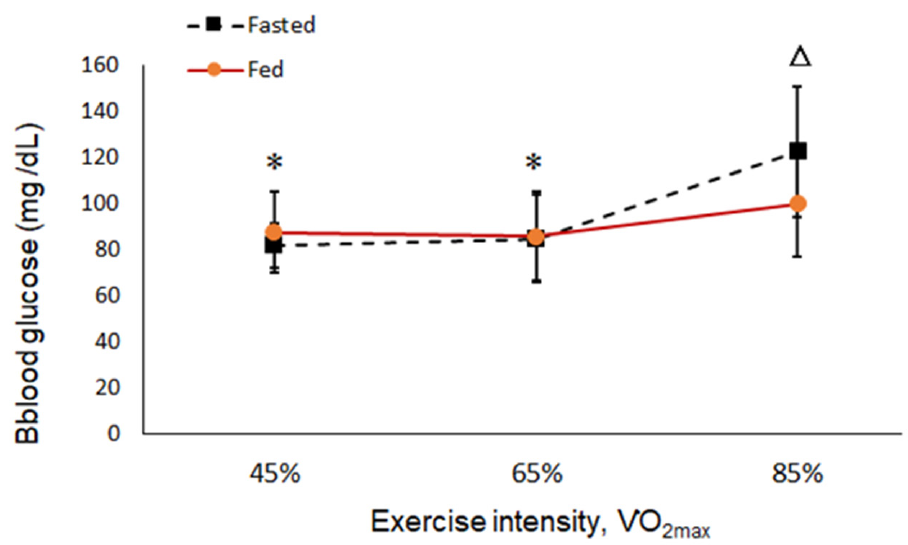
Figure 4. Blood glucose concentration (BGLU) at each exercise intensity in the fed and fasted state. “ △ ”: Significant difference between the fed and fasted state at the same intensity ( p < 0.05). “*”: Significant difference compared to 85% VO 2max in the same state ( p < 0.05).